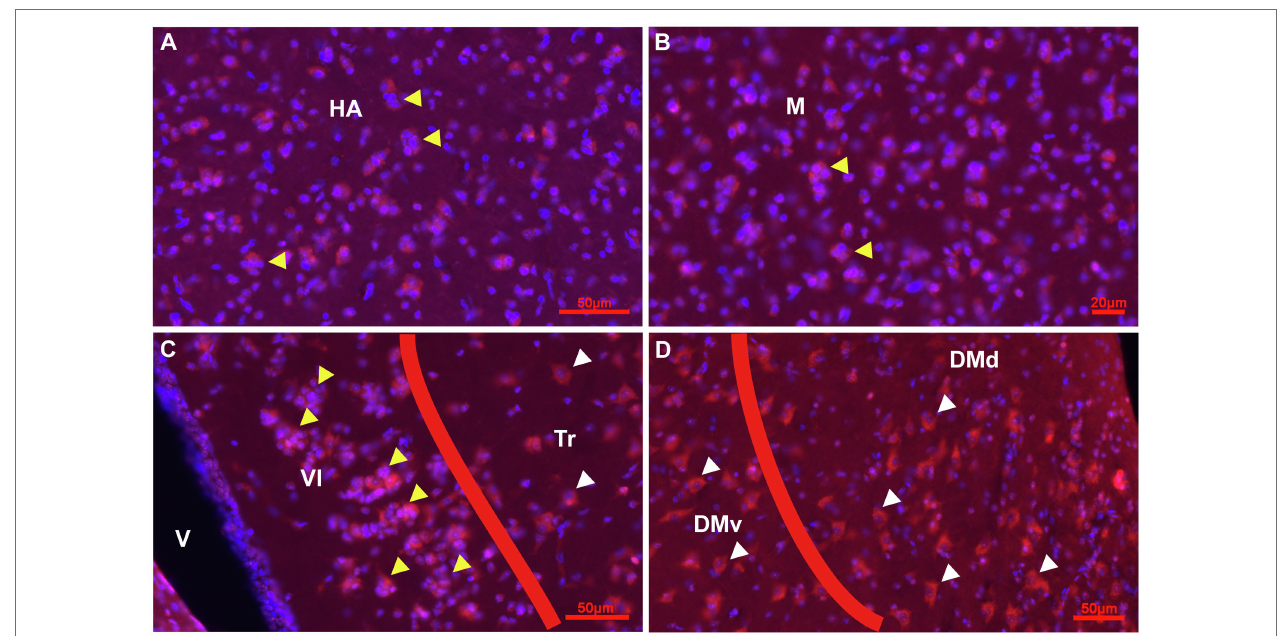
FIGURE 5 | Prox1 expression in combination with Hoechst staining in the adult pigeon forebrain. (A) Detail of Cluster Prox1 + (red)/Hoechst+ (blue), i.e., red-pinkish cells of stage 2 in the parenchym of HA (yellow arrowheads) at atlas level 12.25. (B) Detail of Cluster Prox1+ cells of stage 2 in the parenchym of M (yellow arrowheads) at atlas level A7.75. (C,D) Prox1+ cells in the HF at atlas level A7.75. Clusters occur mainly in VL (yellow arrowheads), while Tr, DMv and DMd exhibited Prox1+ cells of stage 3 and 4 (white arrowheads). Apart from clusters, Prox1 immunostaining was mainly observed in the soma of